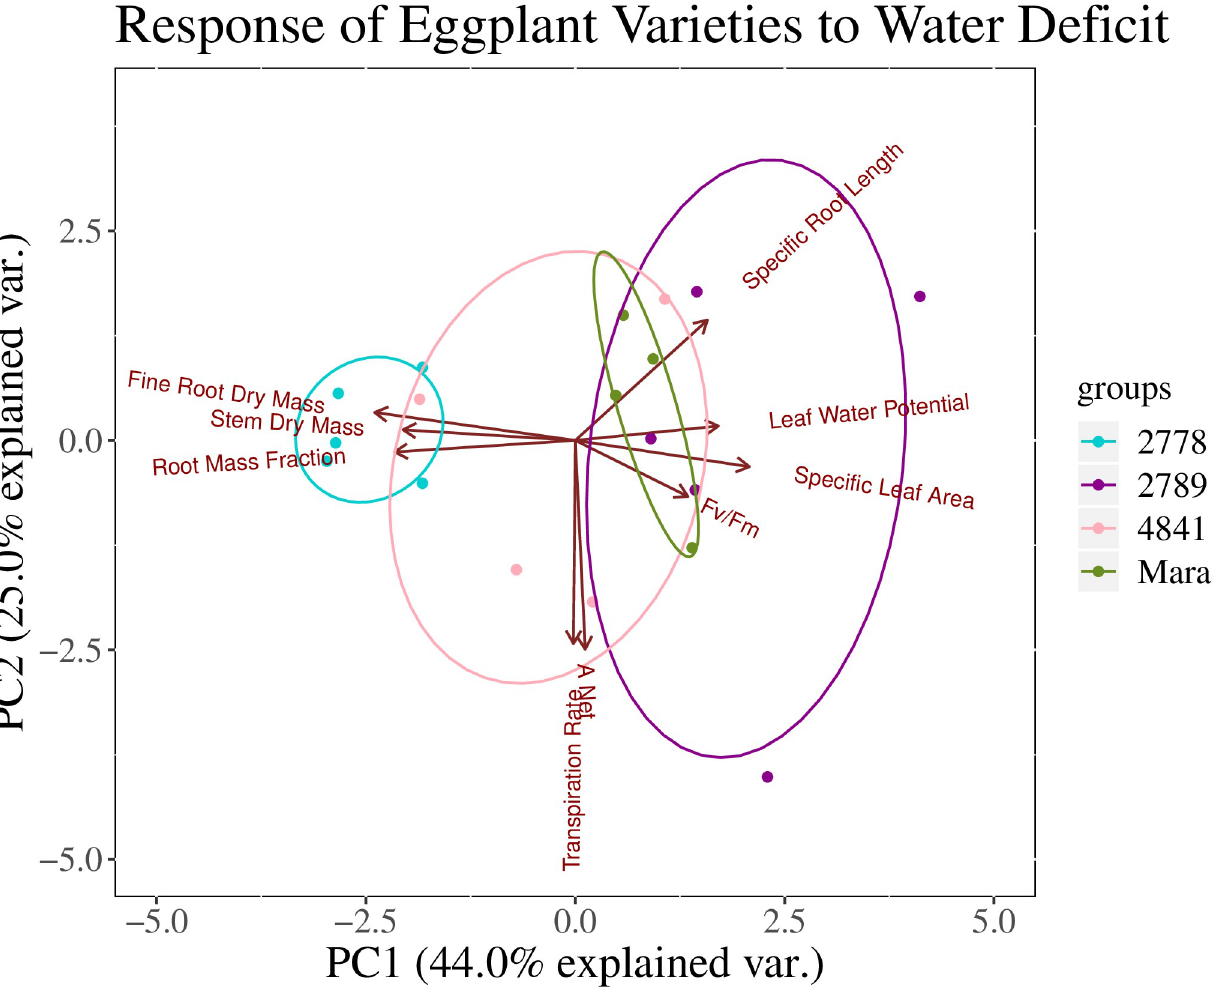
Fig 5. Principal component analysis of the water stressed samples prior to recovery watering. Loading arrows indicate the magnitude and direction of trait variation (9 traits) underlying the sample distribution. Ellipses indicate groupings by genotype.